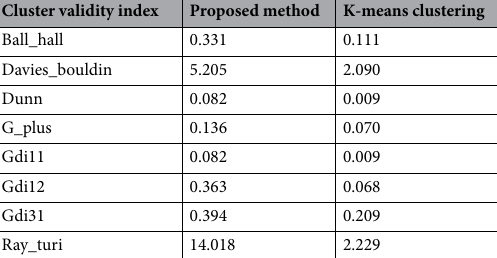
Cluster validity